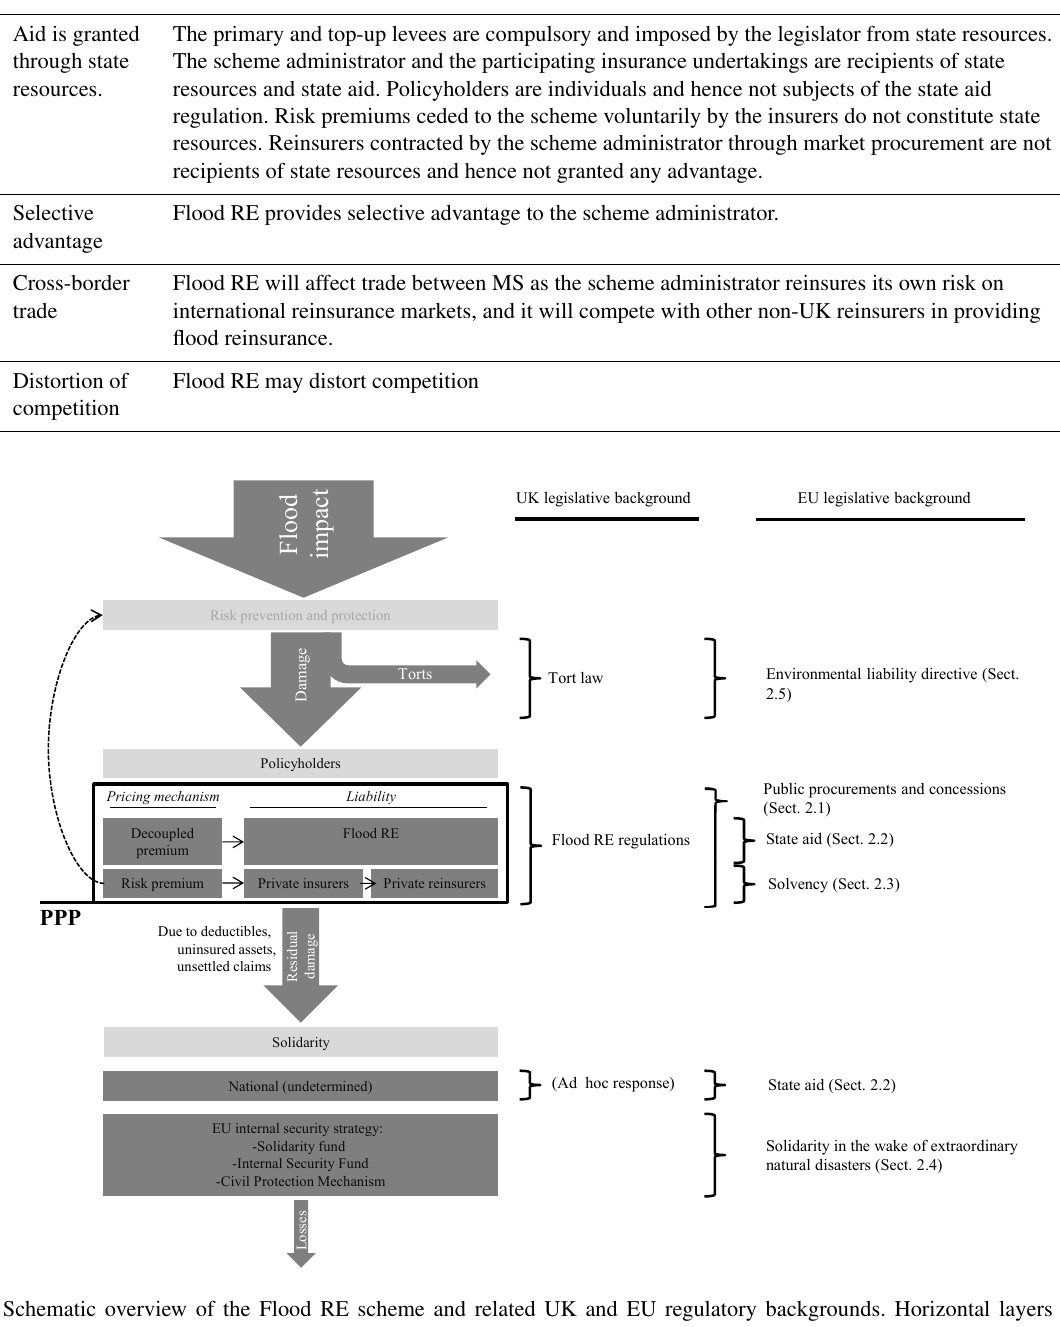
Figure 1. Schematic overview of the Flood RE scheme and related UK and EU regulatory backgrounds. Horizontal layers signify the instruments used to short-circuit the link between impact, damages and losses (grey vertical arrows). The dashed line represents the link between risk-based pricing and disaster risk reduction. The square with the thick outline frames the public–private partnership (PPP). The two columns to the right summarize the relevant UK and EU legislative framework and regulations per layer, and the section of the paper where they are